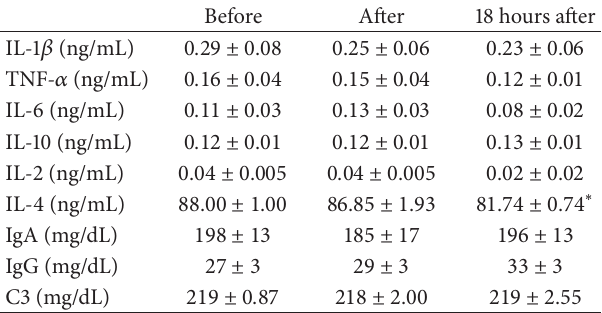
Table 1: Effects of classical ballet class on the serum concentrations of IL-1 𝛽 , TNF- 𝛼 , IL-6, IL-10, IL-2, IL-4 and C3 were quantified in the plasma, and serum concentrations of IgA and IgG were quantified in the serum of dancers before, immediately after and 18 hours after a ballet class.